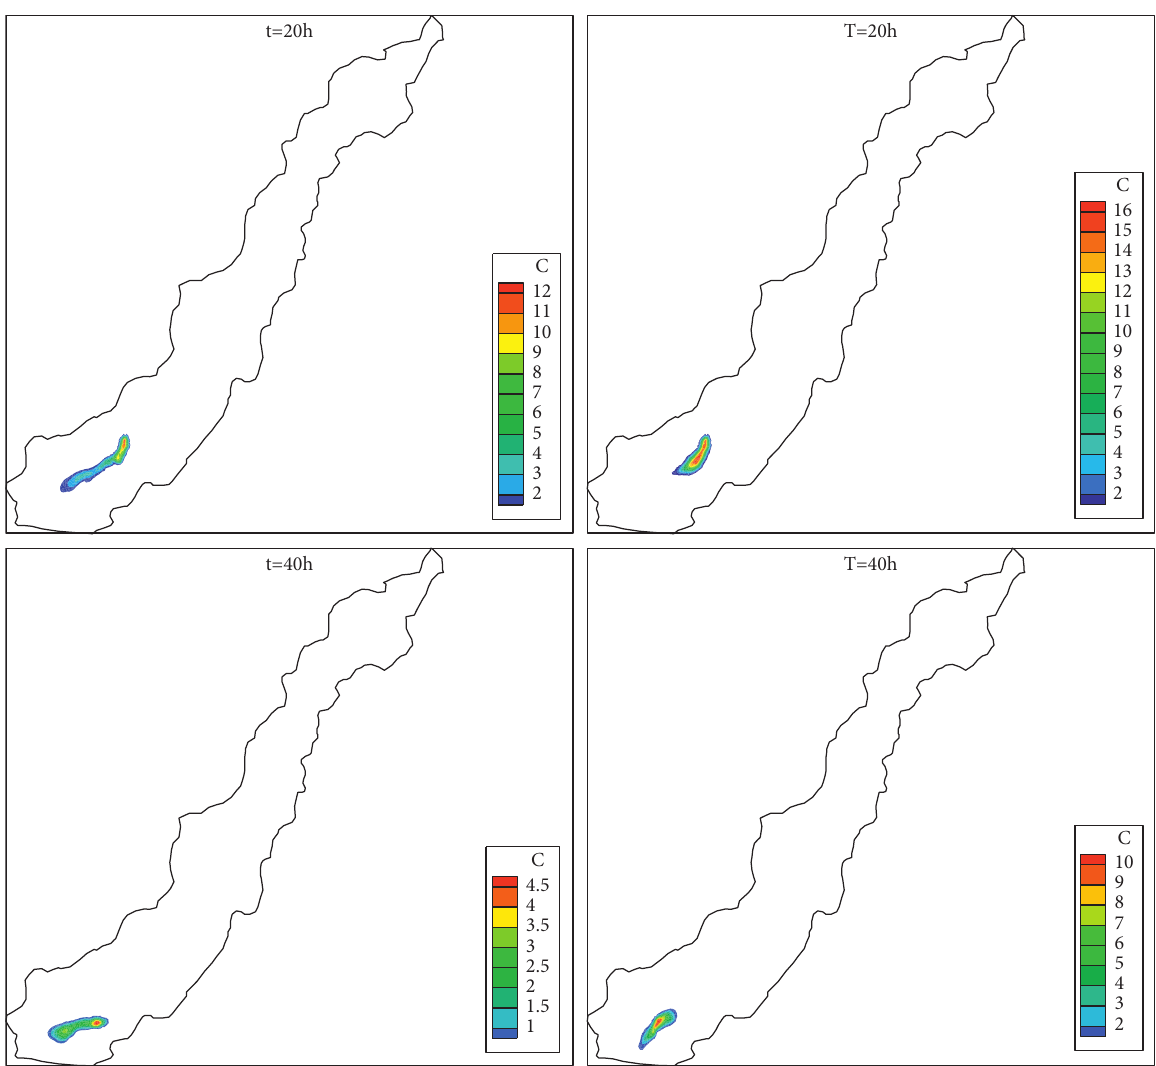
Figure 12: The transport of the pollutants without (left) and with (right) considering land-use type.